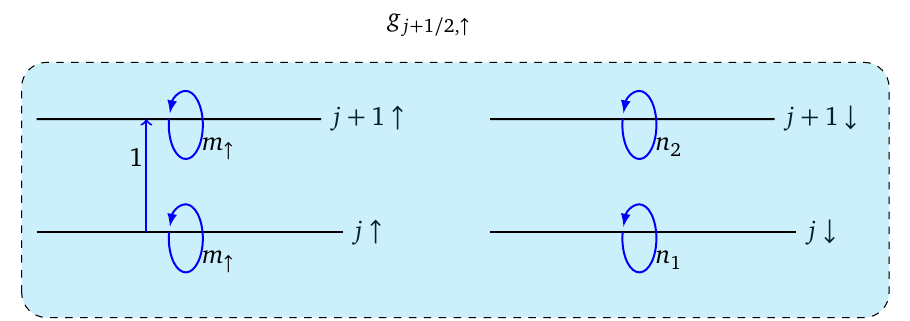
Figure 3: Correlated inter-wire backscattering stabilizing a semi-quantized quantum Hall state. Arrows indicate tunnelling between and backscattering within wires. The numbers of scattered electrons is indicated besides each